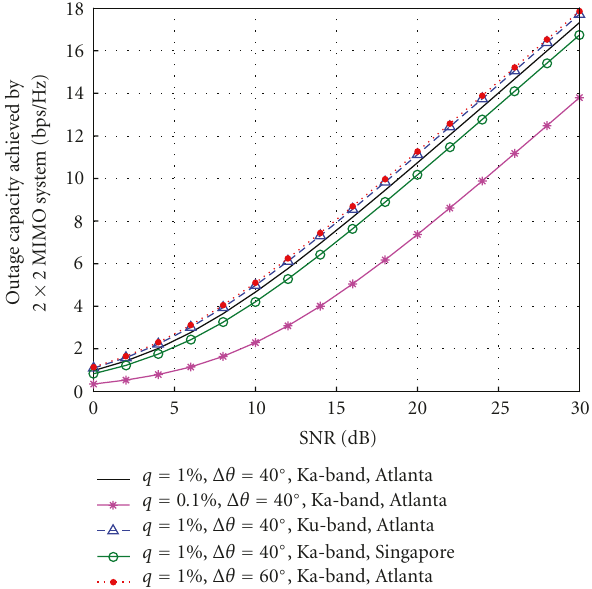
Figure 6: Outage capacity versus SNR for a satellite 2 × 2 MIMO spatial multiplexing system. E ff ect of capacity outage probability q , angular separation Δ θ , operating frequency f , and climatic condi- tions over the serviced